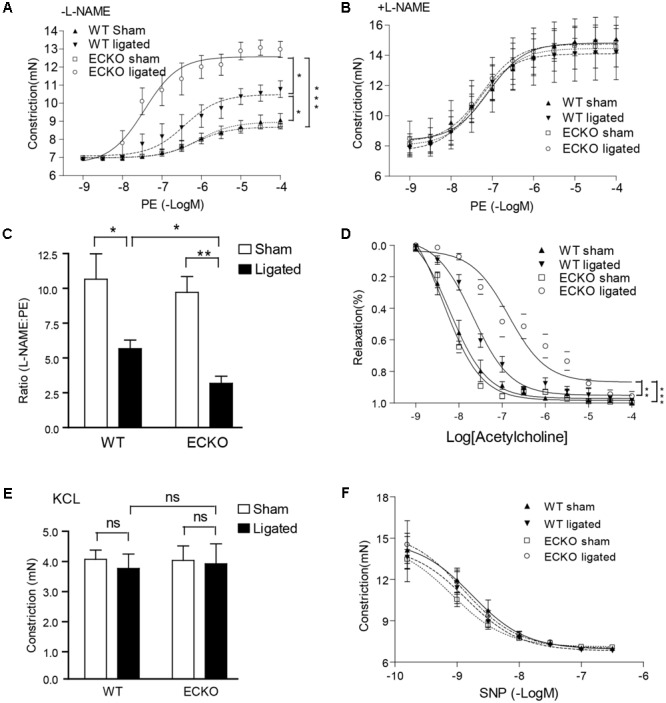
AIP1-ECKO enhances ligation-induced EC dysfunction prior to VSMC accumulations. Three days post-ligation, carotid arteries were harvested for vessel function assays. (A) Common carotid artery from AIP1-ECKO mice showed an enhanced response to PE. Common carotid artery rings were contracted with PE at a full range of doses (10-9 to 10-4 mol/L). Constriction force (mN) is shown. (B) AIP1-ECKO had reduced basal NO. Common carotid artery rings were incubated with the NOS inhibitor L-NAME to remove basal NO synthesis and then contracted with PE as described in (A). (C) Ratio of EC50 to PE in the presence versus absence of L-NAME (100 μmol/L) was shown. (D) Arteries from AIP1-ECKO alter the response to Ach. Artery rings were precontracted with PE and then relaxed with Ach at a full range of doses (10-9 to 10-4 mol/L). % of relaxation is shown. (E) AIP1-ECKO had normal vessel constriction in response to KCl. Common carotid artery rings were contracted with 50 mmol/L KCl. (F) AIP1-ECKO had no effects on vessel relaxation to the NO donor drug SNP. Common carotid artery rings were incubated with a NOS inhibitor L-NAME to remove basal NO synthesis followed by a pre-contraction with PE as mentioned above and were then relaxed with SNP at a full range of doses (10-9 to 10-6 mol/L). Data are presented are mean ± SEM, with n = 5 animals and eight artery rings per animal. ∗P < 0.05, ∗∗P < 0.01, ∗∗∗P < 0.001.